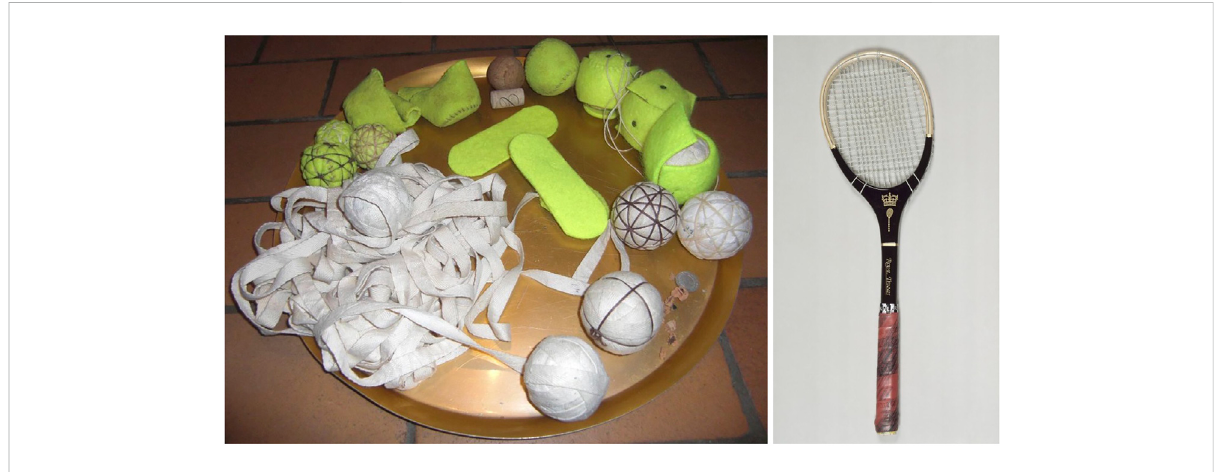
FIGURE 3 Balls and racket are still assembled by “ Maîtres Paumiers ”